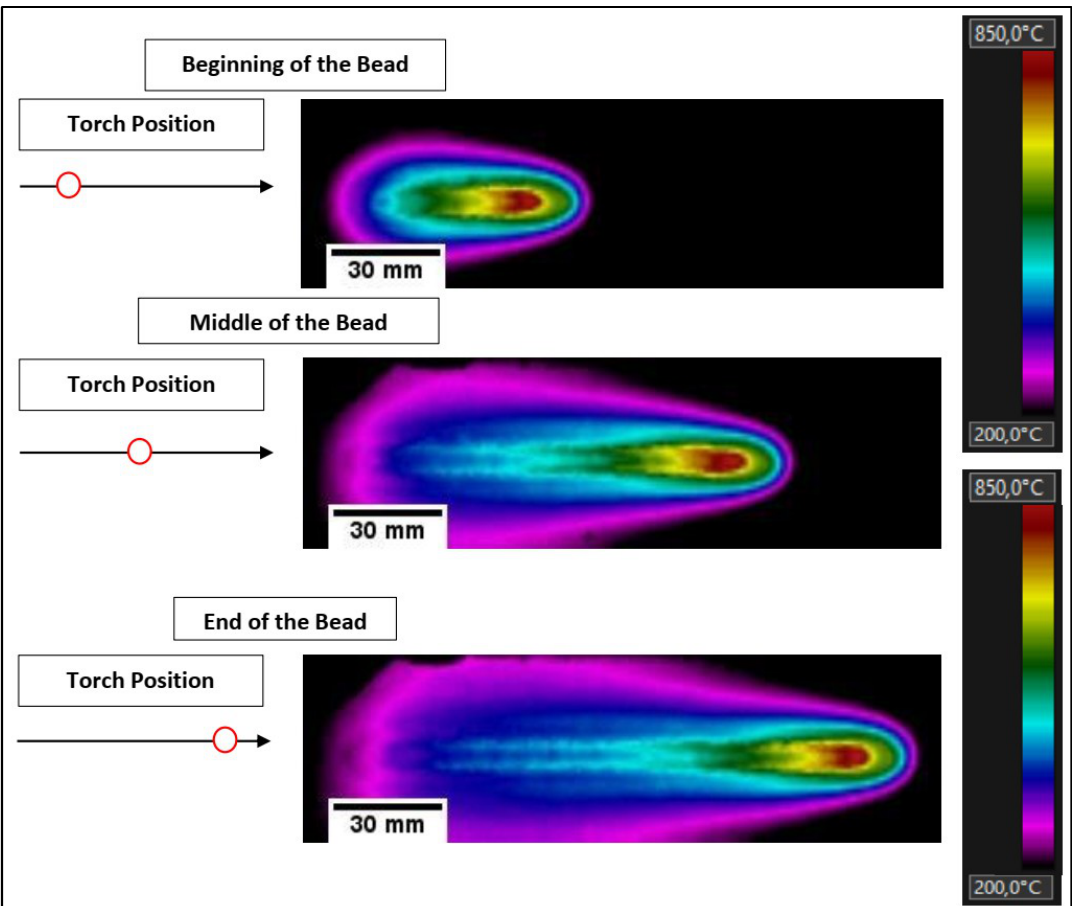
Figure 9. Thermal profile at the plate backside from the deposition T1L (linear) at different welding times (progressively advancing the torch position).